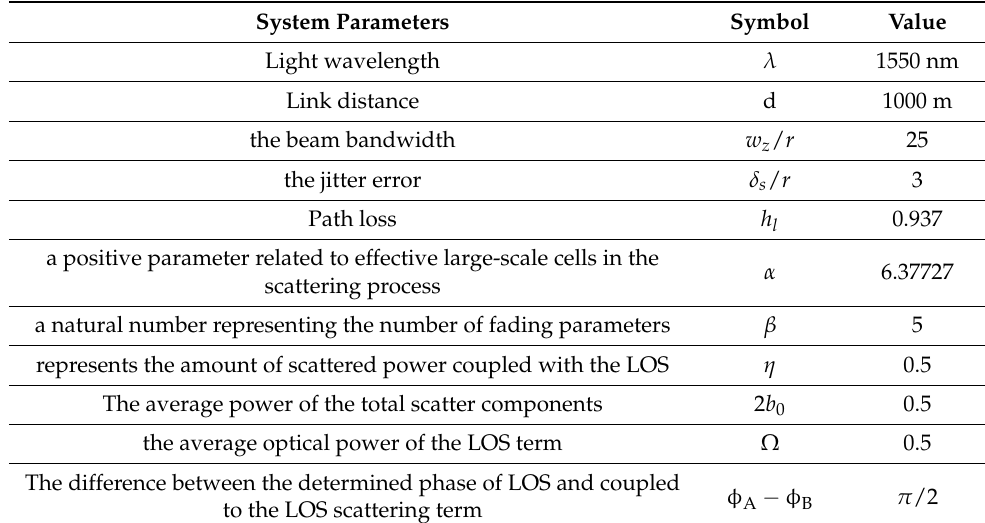
Table 2. Selection of simulation parameters for GSTBC-EFOGSM FSO